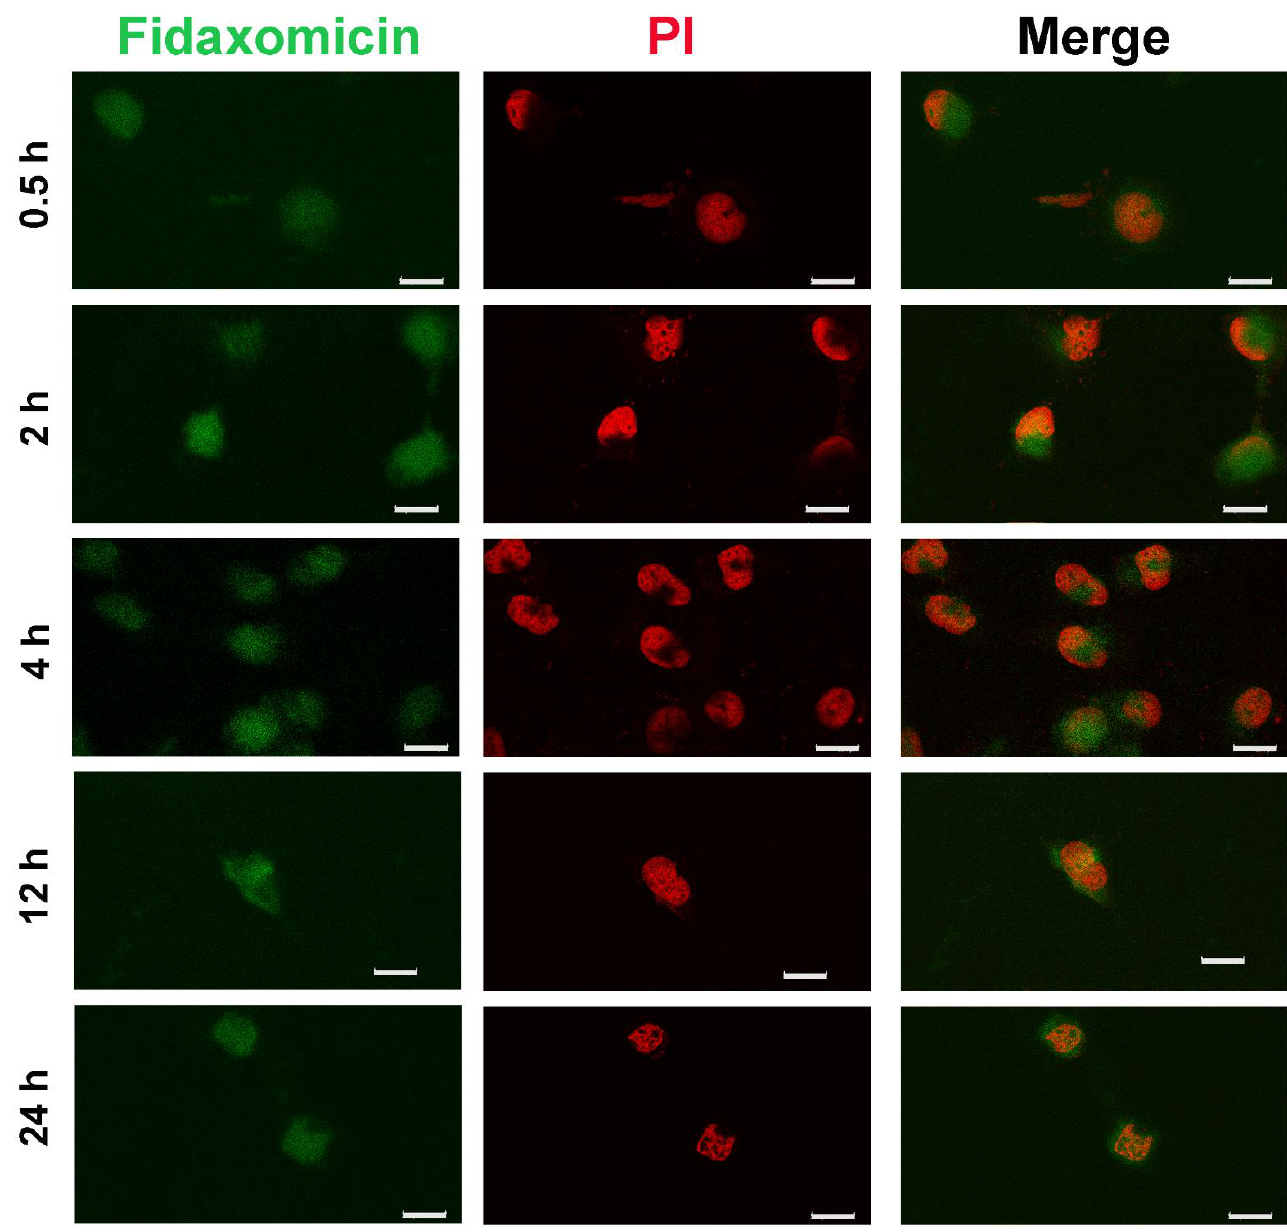
Figure 6. Cellular internalization of fidaxomicin in 4T1 cells. The confocal fluorescence images of 4T1 cells were obtained after incubation with fidaxomicin for 0.5, 2, 4, 12, and 24 h. Scale bar: 20 μm.